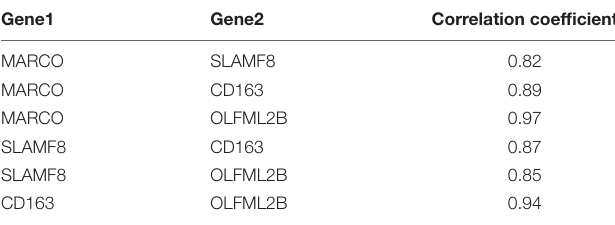
Table of the Spearman correlation from the AECOPD and stable COPD (stabilization of AECOPD patients after treatment) patients with the 5 genes.